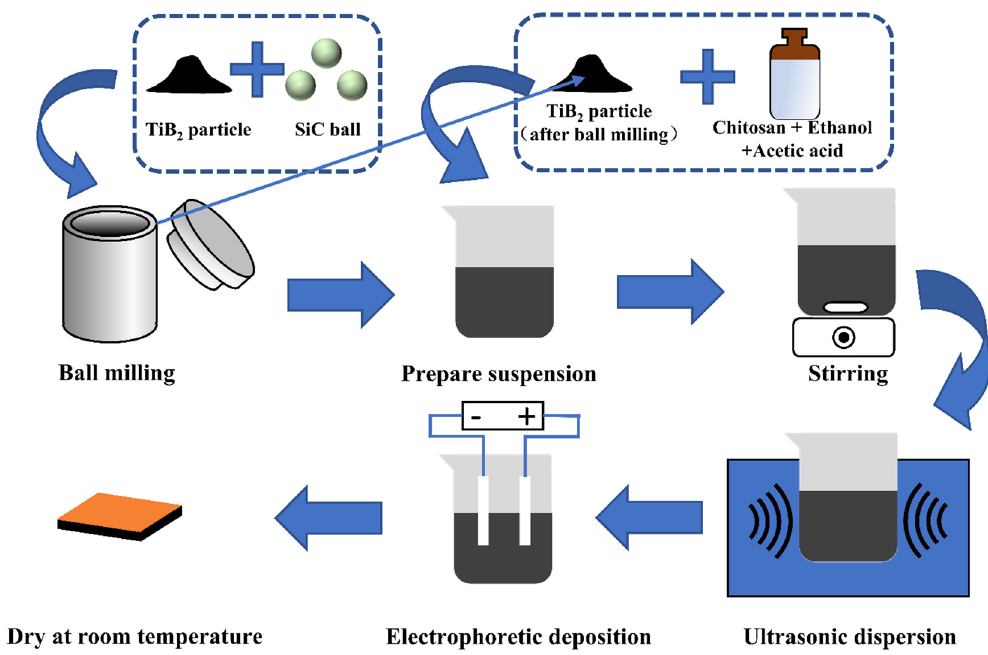
Figure 1. The experiment flows.